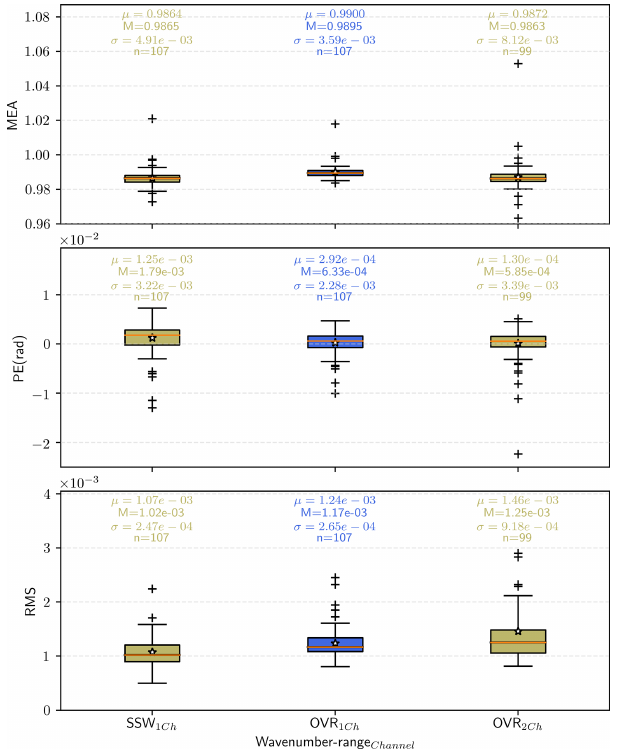
Figure 12. Box plots comparison for the three-wavenumber ranges used with the open-path method showing the MEAs, PEs and